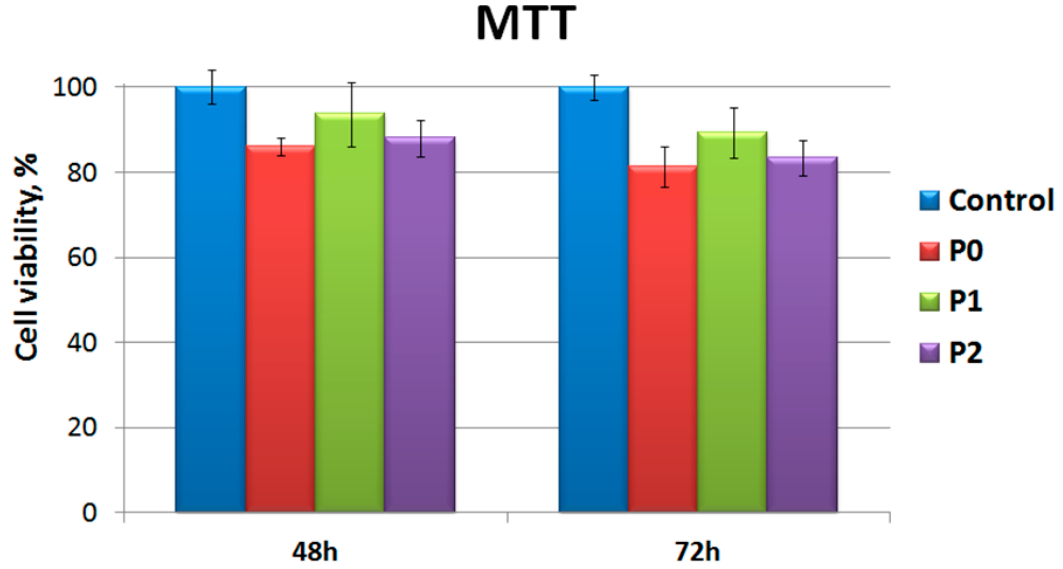
Figure 9. MTT assay results of MC3T3-E1 cells on the P0, P1 and P2.